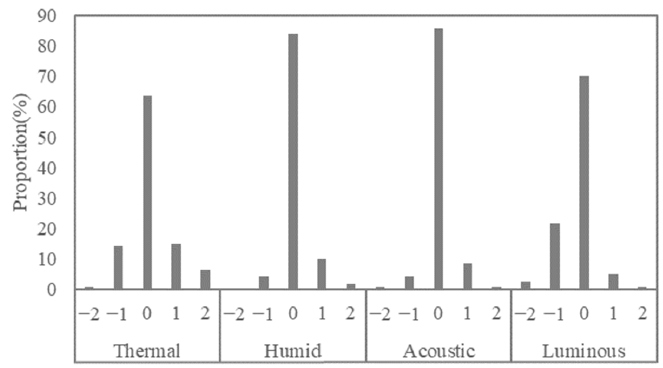
Figure 2. Environmental sensation